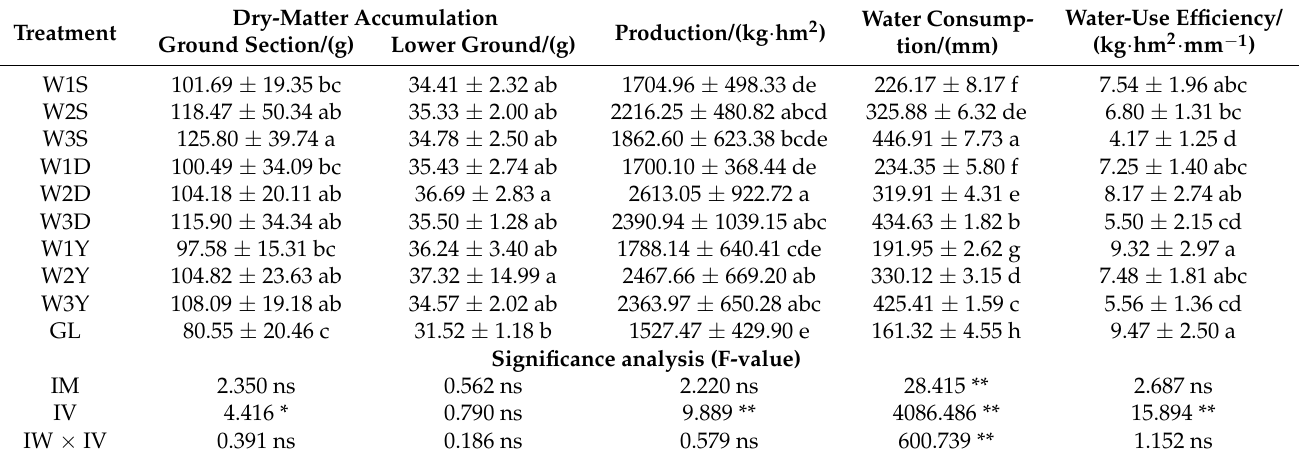
Table 4. Effect of different micro-irrigation methods on dry-matter accumulation, yield, and water-use efficiency in intercropping